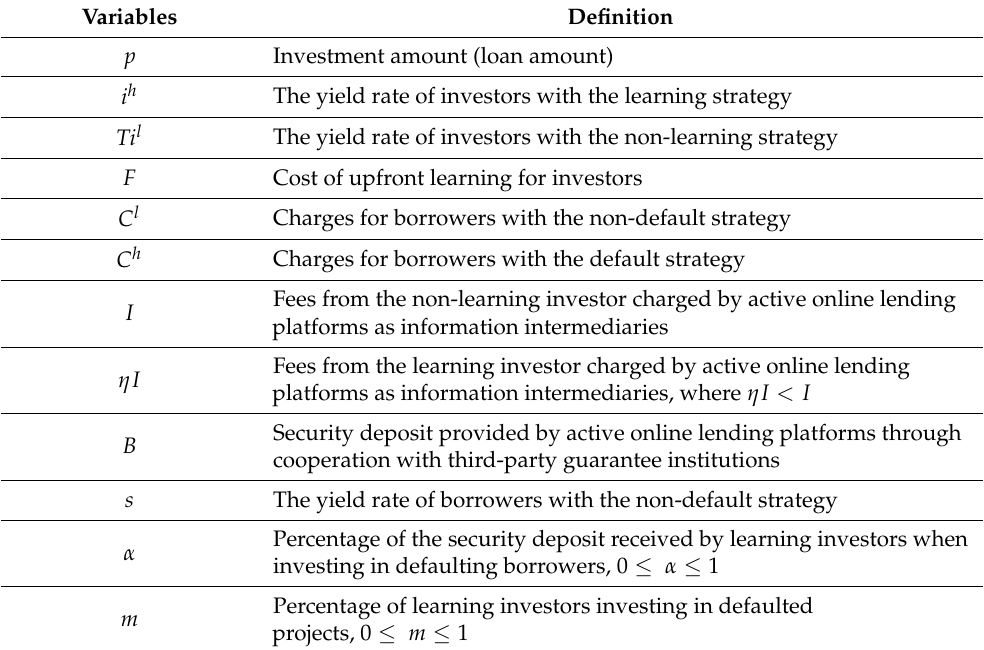
Table 1. Variable Description.